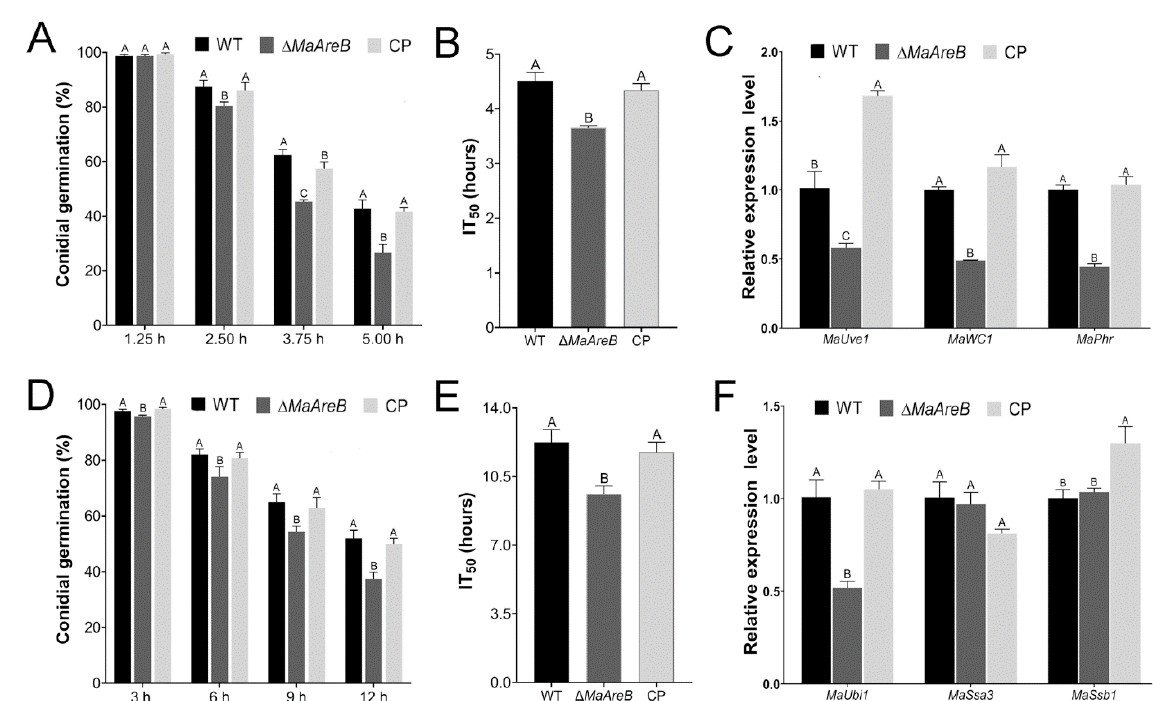
Figure 4. Deletion of MaAreB weakened tolerances to UV-B irradiation and heat-shock. Conidial germination of the WT, ∆ MaAreB and CP strains with UV-B irradiation ( A ) and heat-shock ( D ) treatments. The IT 50 of each strain with UV-B irradiation ( B ) and heat-shock ( E ) treatments. Transcription level of genes involved in fungal tolerances to UV-B irradiation ( C ) and heat-shock ( F ). A & B, A & C or B & C, p < 0.05 (Tukey’s HSD). The p -values in Figure 4A-F are listed in supplementary Table S3.